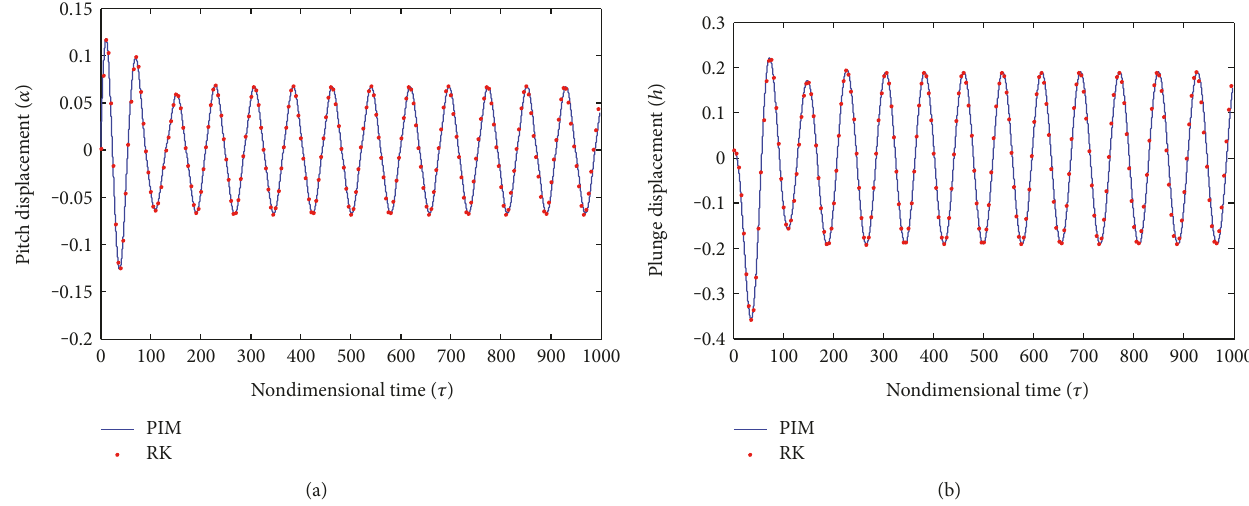
Figure 6: Time histories of the aeroelastic system at U / U